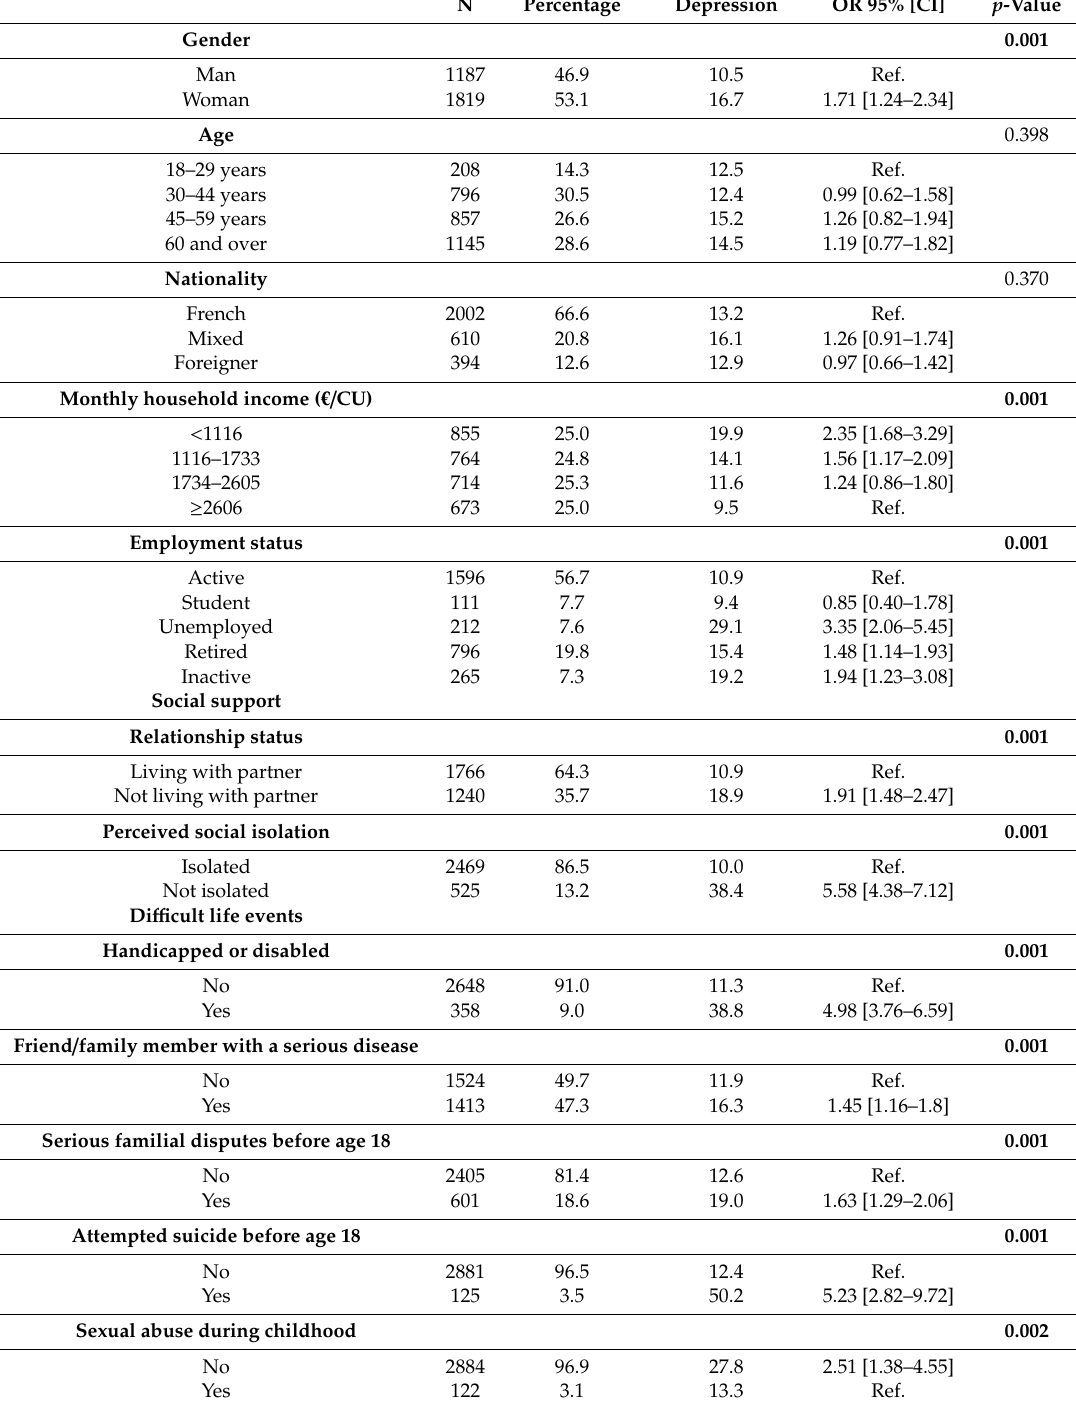
Table A1. Univariate analysis of the association between individual characteristics, individual perception of neighborhood, and the cumulative exposure score and depression, SIRS,